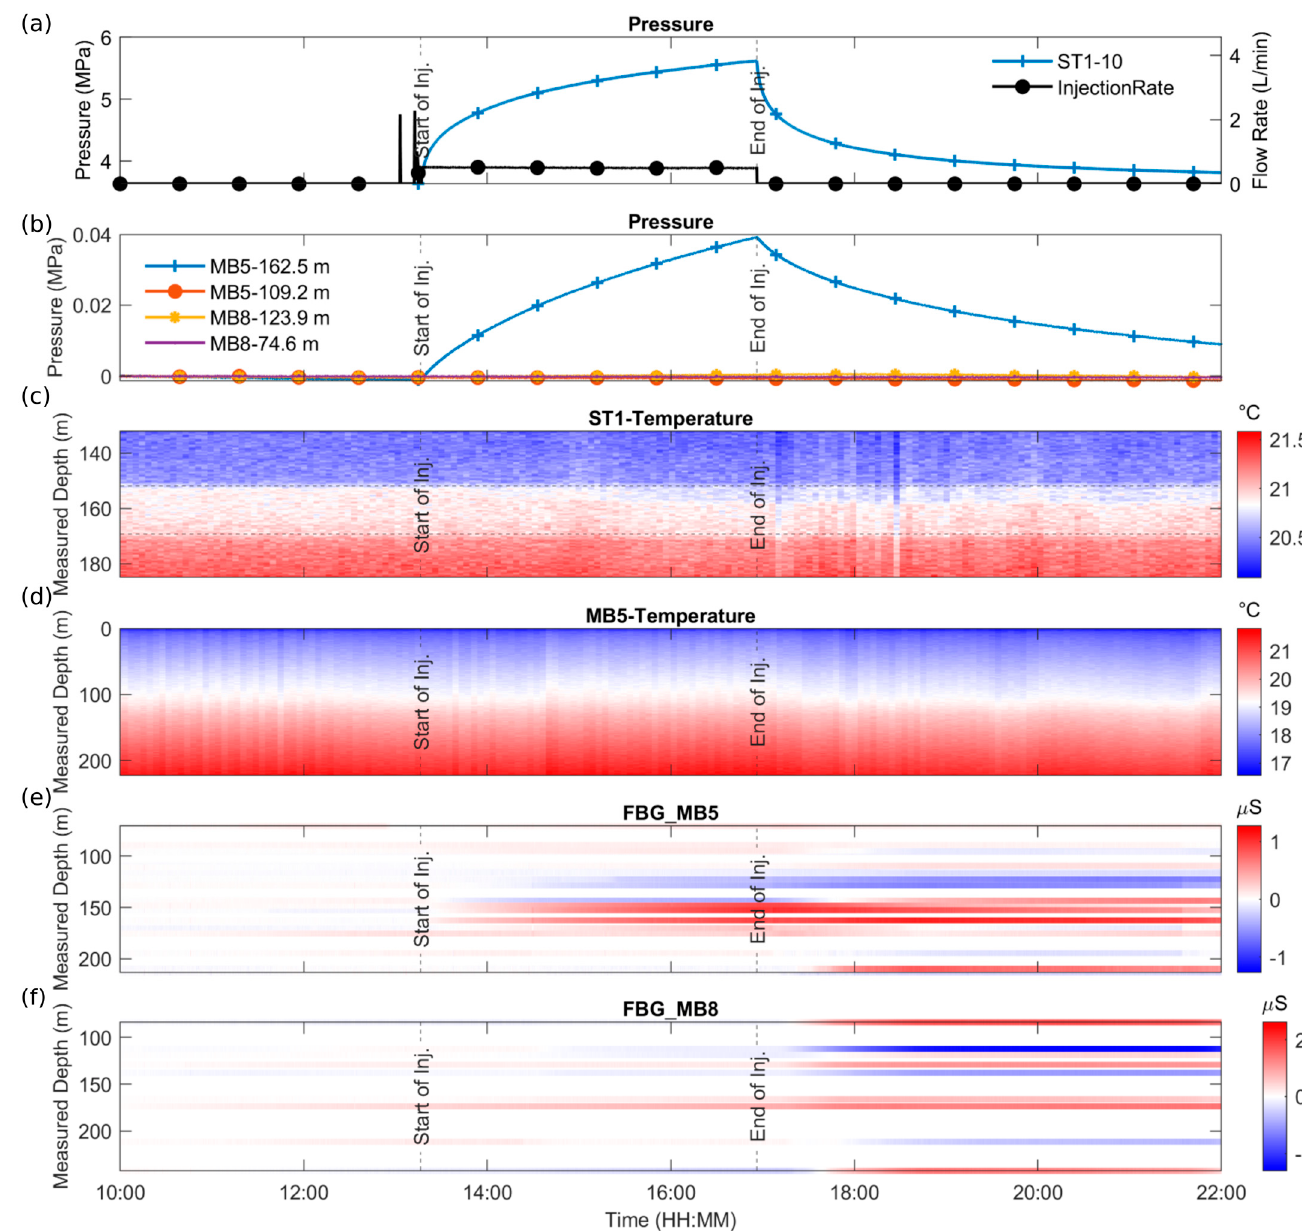
Figure 9. Data examples for BRP sensors (geomechanics). The thermo-hydromechanical monitoring of the reservoir volume during an injection operation in Interval-10 in the ST1 wellbore is shown: ( a ) injection pressure (measured downhole) and flow rate; ( b ) pressure change measured at four CTPP sensors in MB5 and MB8 wellbores, all zeroed at the first data point in the plot for comparison purpose; ( c ) temperature profile measured using DTS in injection wellbore ST1 (the packed injection interval is bounded with dotted lines); ( d ) temperature profile measured using DTS in monitoring borehole MB5; and ( e , f ) strain measurements in two wellbores, MB5 and MB8, using FBG sensors with compression shown as negative values, smoothed over 20 s time window. The start and end of the injection are marked in all subplots. The grouted CTPP pressure sensor MB5-162.5 m and the corresponding collocated FBG sensor at the depth of 162.5 m in MB5 clearly show the hydromechanical connection to the injection interval (Interval 10) in the ST1 wellbore.